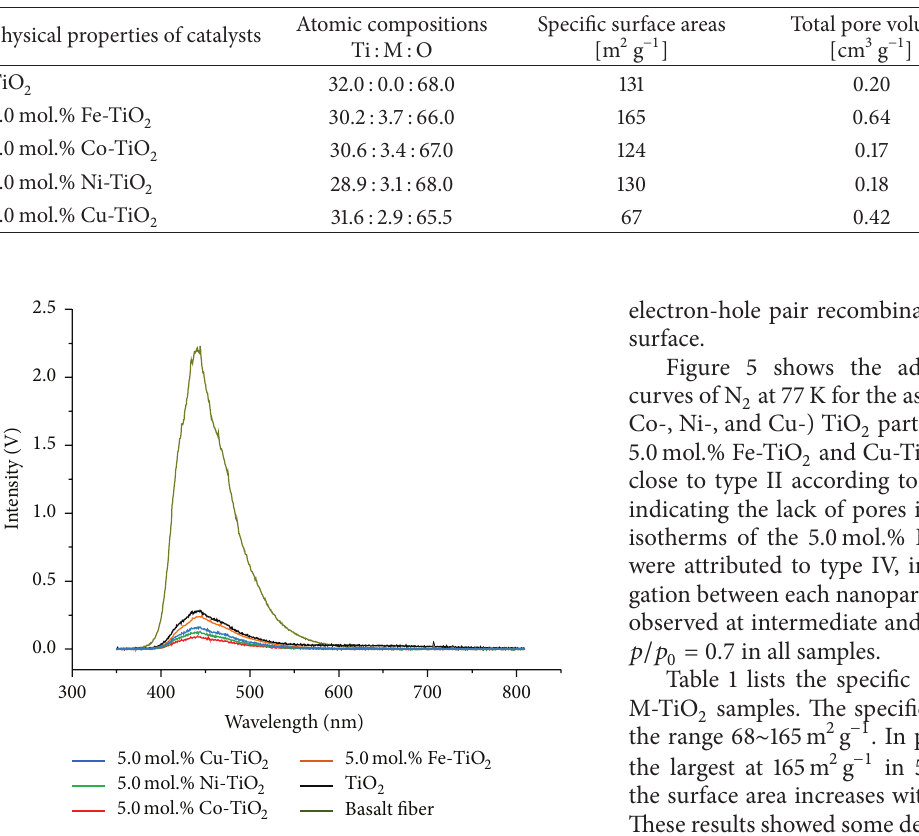
Figure 4: PL spectra of the prepared 5.0 mol.% M-TiO 2 particles.